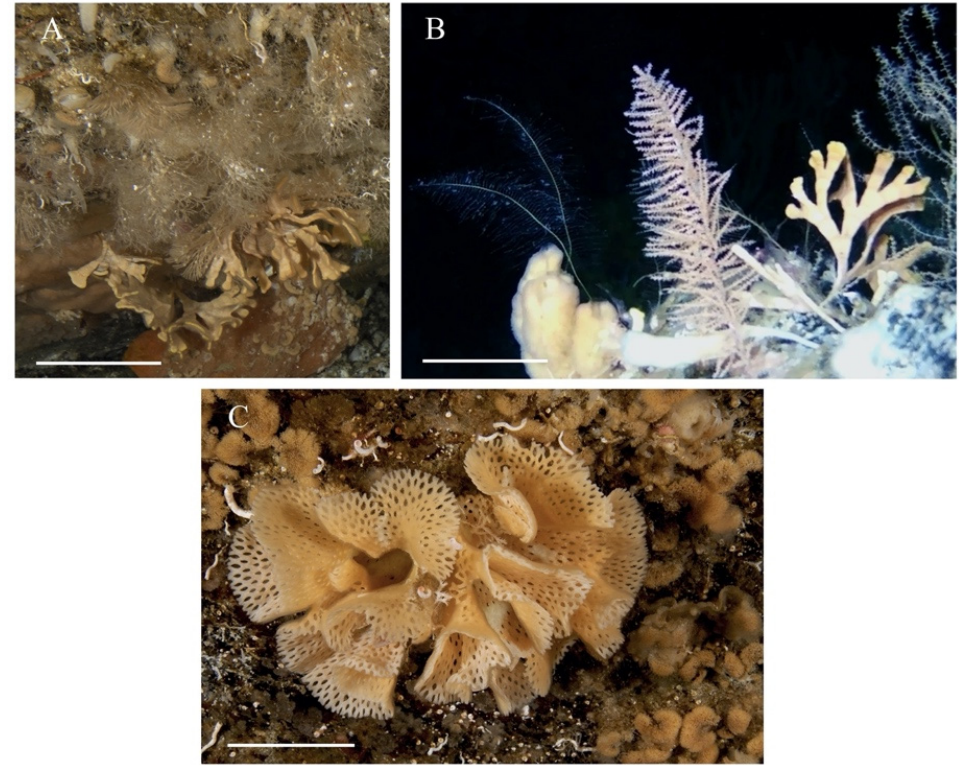
Figure 2. Bryozoan colonies in their natural habitat ( A ) Cellarinella sp. 1 living at 25 m depth; ( B ) Cellarinella sp. 2 (right) living at 110 m depth; ( C ) Reteporella sp. living at 25 m depth. Scale bars: 3 cm. Pictures: A, C: P. Kuklinski; B: E. Spirandelli.